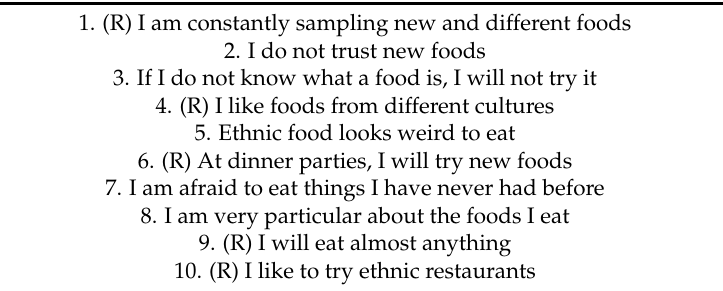
Table 2. The Food Neophobia Scale (FNS)